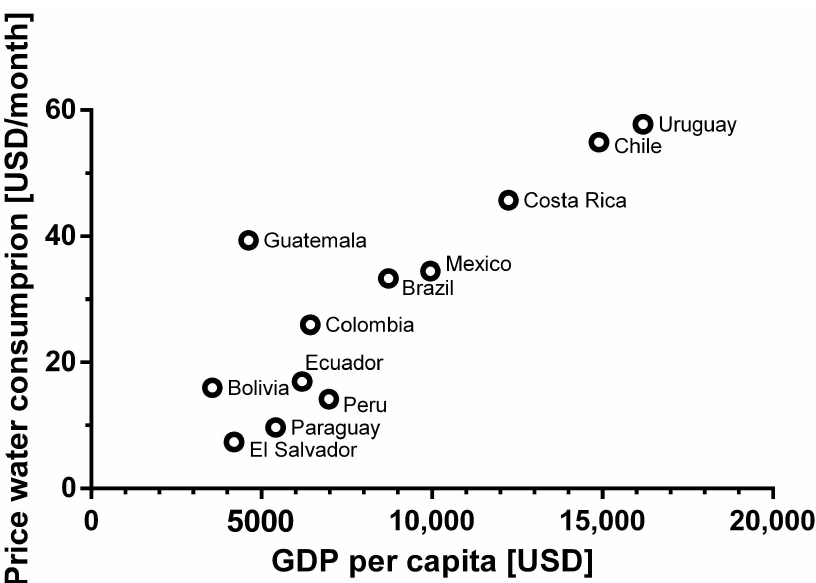
Figure 6. Price of the average water consumption of a household (30 m 3 /month) versus Gross Domestic Product (GDP) per capita in some countries of Latin America and the Caribbean. Source: GDP values were taken from The World Bank (2019) [140] and the water rates were taken from [149–160].